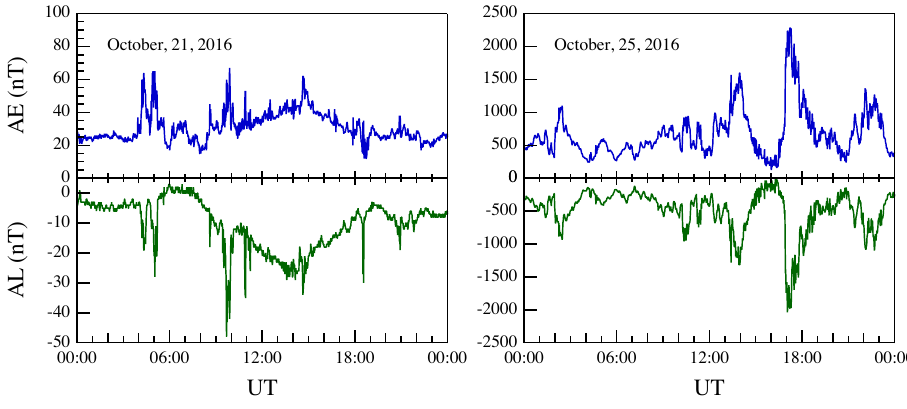
Figure 1. The AE and AL geomagnetic indices for the two selected days, 21 October 2016 (on the left) and 25 October 2016 (on the